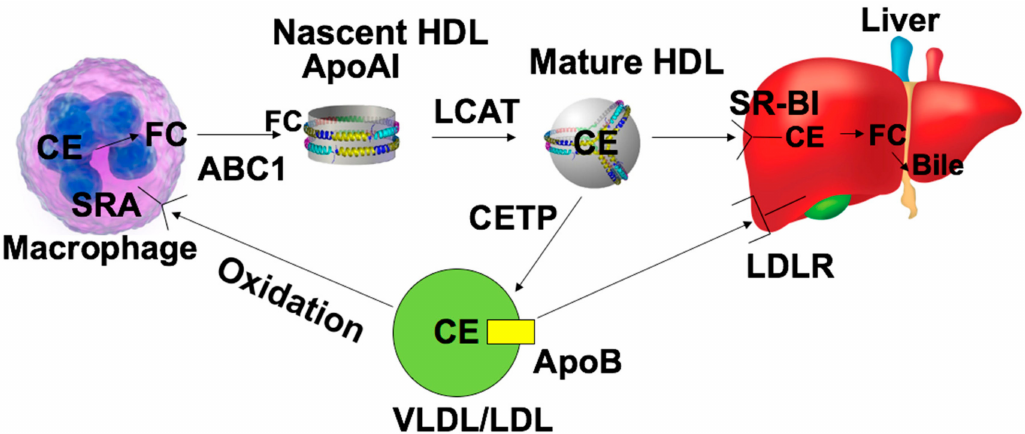
Figure 1. In vivo reverse cholesterol transport (RCT) pathway. Modified low-density lipoproteins (LDLs) are recognized by scavenger receptor A (SRA) and taken up by macrophages, which lead to the formation of a foam cell. Apolipoprotein AI (ApoAI) or nascent high-density lipoproteins (HDLs) promote the cholesterol e ffl ux from foam cells by interacting with ATP-binding cassette transporters (ABC1) ABCA1 or ABCG1. Free cholesterol in HDLs is esterified into cholesteryl ester (CE) by lecithin cholesterol acyltransferase (LCAT) to produce the mature HDL. Liver scavenger receptor class B type I (SR-BI) is responsible for recognition of HDLs and promotes the uptake of cholesterol. CE is de-esterified and converted into bile acid, which is secreted into the bile. In humans, CE can be transported onto ApoB by cholesterol ester transport protein (CETP) and leads to the formation of LDLs or very low-density lipoproteins